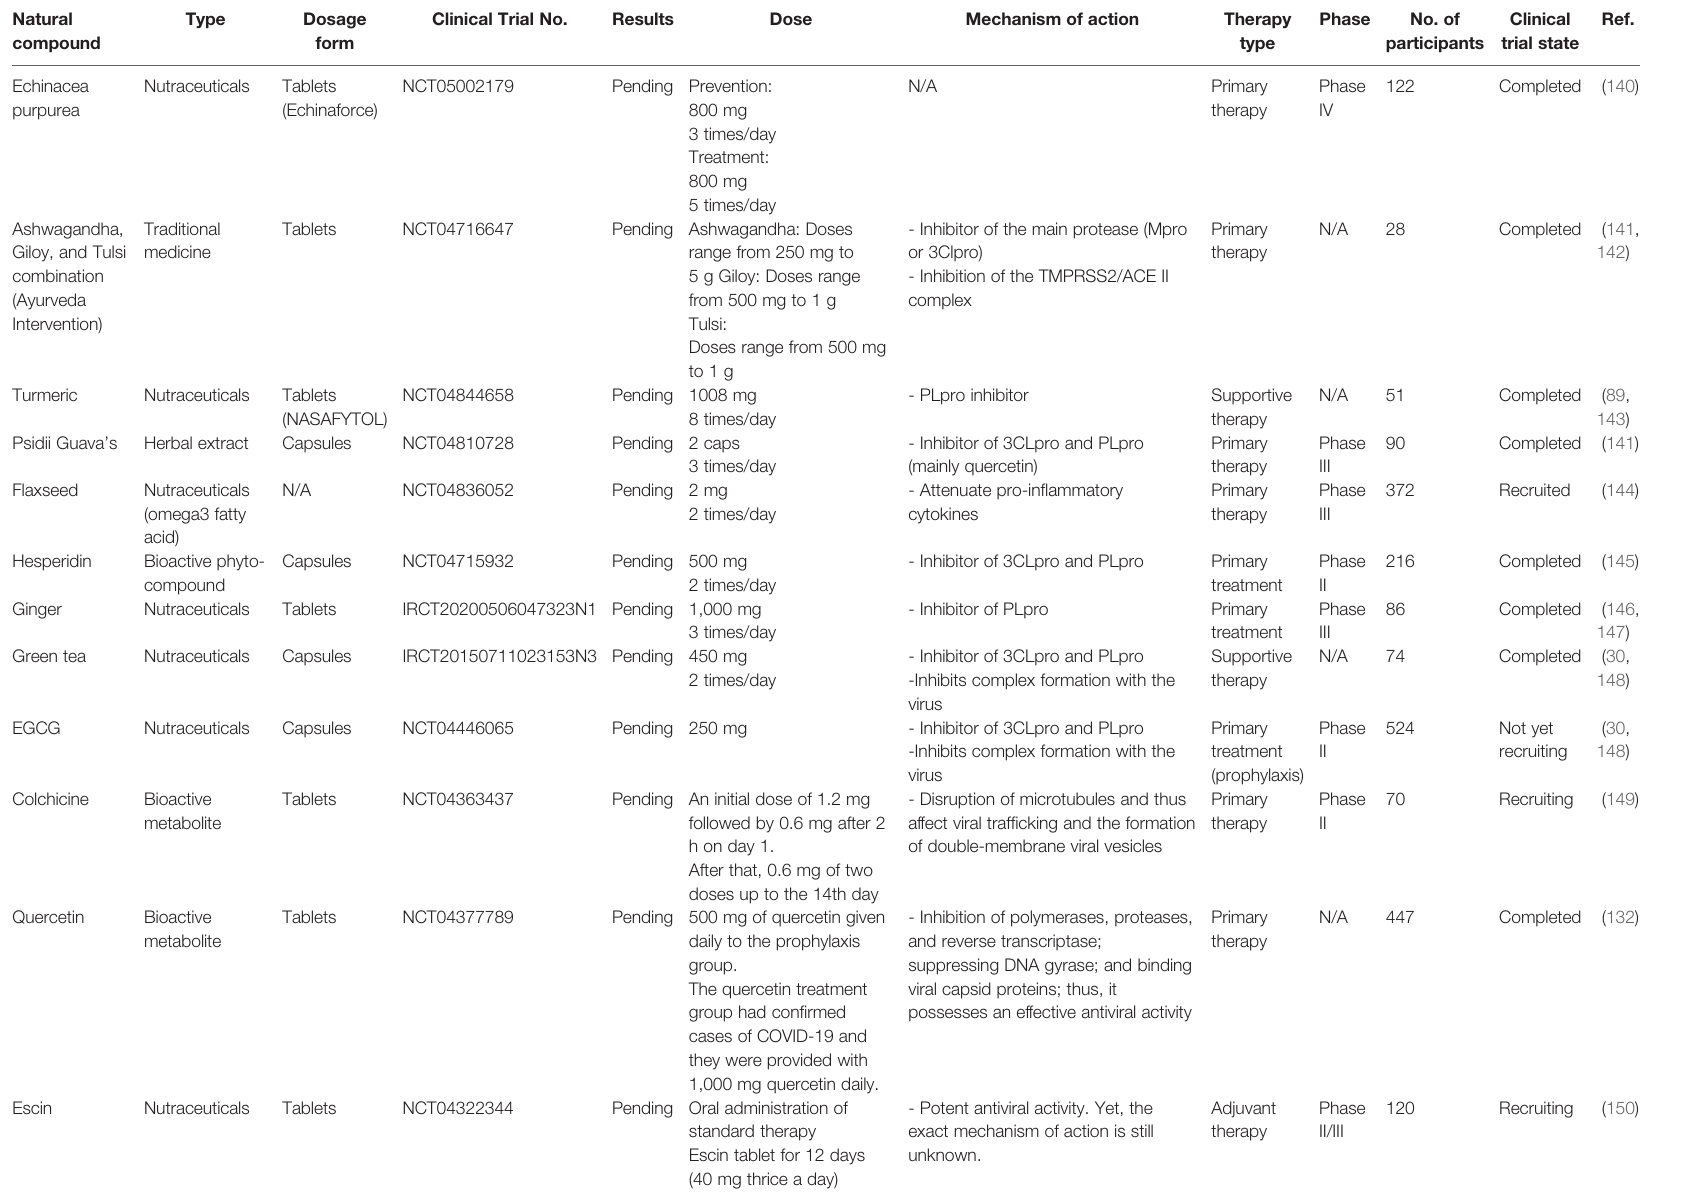
TABLE 3 | Herbal drugs in clinical trials against SARS-CoV-2. Natural